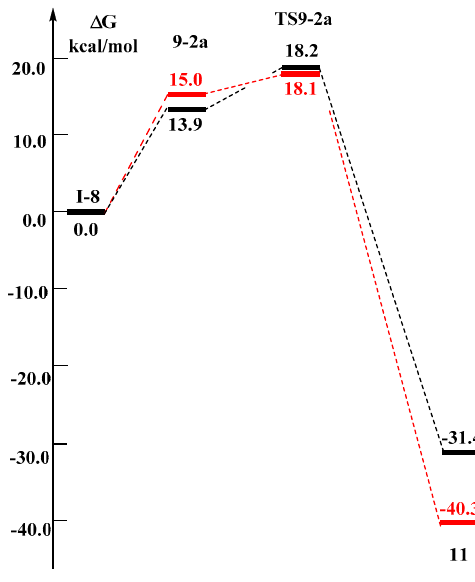
Figure 10. Potential energy profile for reaction between cobalt PNP complex with ( t Bu) 2 P- and (adamantly) 2 P- substituents and ammonia borane.